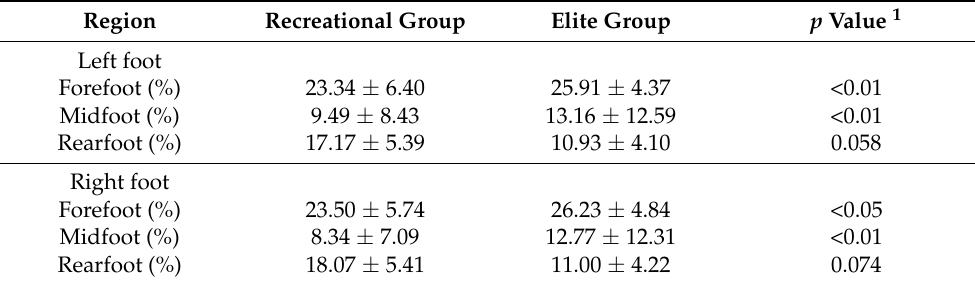
Table 3. Relative Load of the Forefoot, Midfoot, and Rearfoot Regions in Static Standing. Region Recreational Group Elite Group